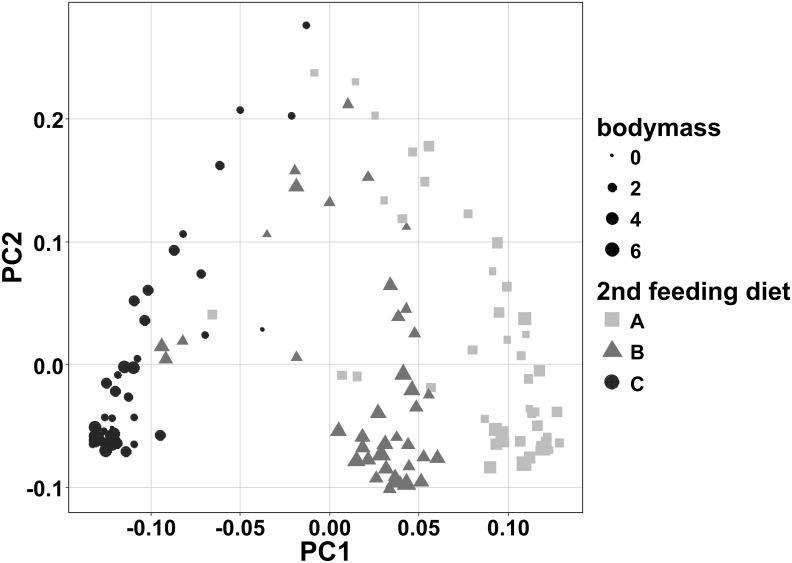
Graphical visualisation of the Principal Component Analysis (PCA) in relation to the second feeding diet and the individual bodymass.The first two principal components PC1 and PC2 (together representing 63% of the variance explained) are presented as axes of the ordination space. Each point represents the intestinal microbiome of one individual fish. Data were pooled for the first feeding diet according to the results of the multivariate model. Different gray shades and shapes of points indicate the three second feeding diets A, B and C. The size of the points indicates the final bodymass of each fish categorized as 0 (i.e. between 0.0g and 2.0g), 2 (i.e. between 2.1g and 4.0g), 4 (i.e. between 2.1g and 4.0g) and 6 (i.e. >6.0g).